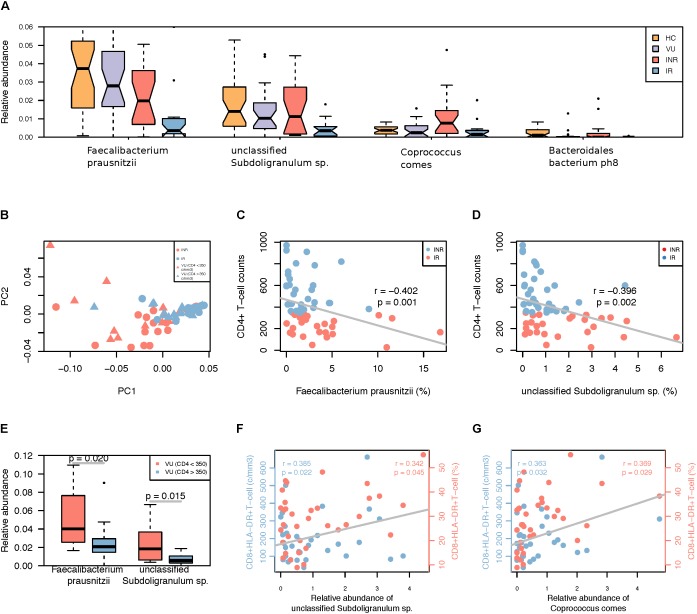
(A) Differentially abundant species in the IR and INR groups. Only the median relative abundances greater than 0.1% of total abundance are included (FDR < 0.3, Wilcoxon rank-sum test corrected by the Benjamini and Hochberg method). (B) PCoA analysis based on the relative abundance of species different between IR and INR groups. (C) Spearman’s correlation between Faecalibacterium prausnitzii and CD4+ T-cell counts among all HIV-1 patients. (D) Spearman’s correlation between unclassified Subdoligranulum sp. and CD4+ T-cell counts among all HIV-1 patients. (E) Relative abundance of the two species in the subgroup of VU group based on the CD4+ T-cell counts. (F) Spearman’s correlation between unclassified Subdoligranulum sp. and CD8+HLA-DR+ T-cell counts and ratio in the IR and INR groups. Blue: correlation between unclassified Subdoligranulum sp. and CD8+HLA-DR+ T-cell counts; Red: correlation between unclassified Subdoligranulum sp. and CD8+HLA-DR+ T-cell ratio. (G) Spearman’s correlation between C. comes and CD8+HLA-DR+ T-cell counts and ratio in the IR and INR groups. Blue: correlation between C. comes and CD8+HLA-DR+ T-cell counts; Red: correlation between C. comes and CD8+HLA-DR+ T-cell ratio.